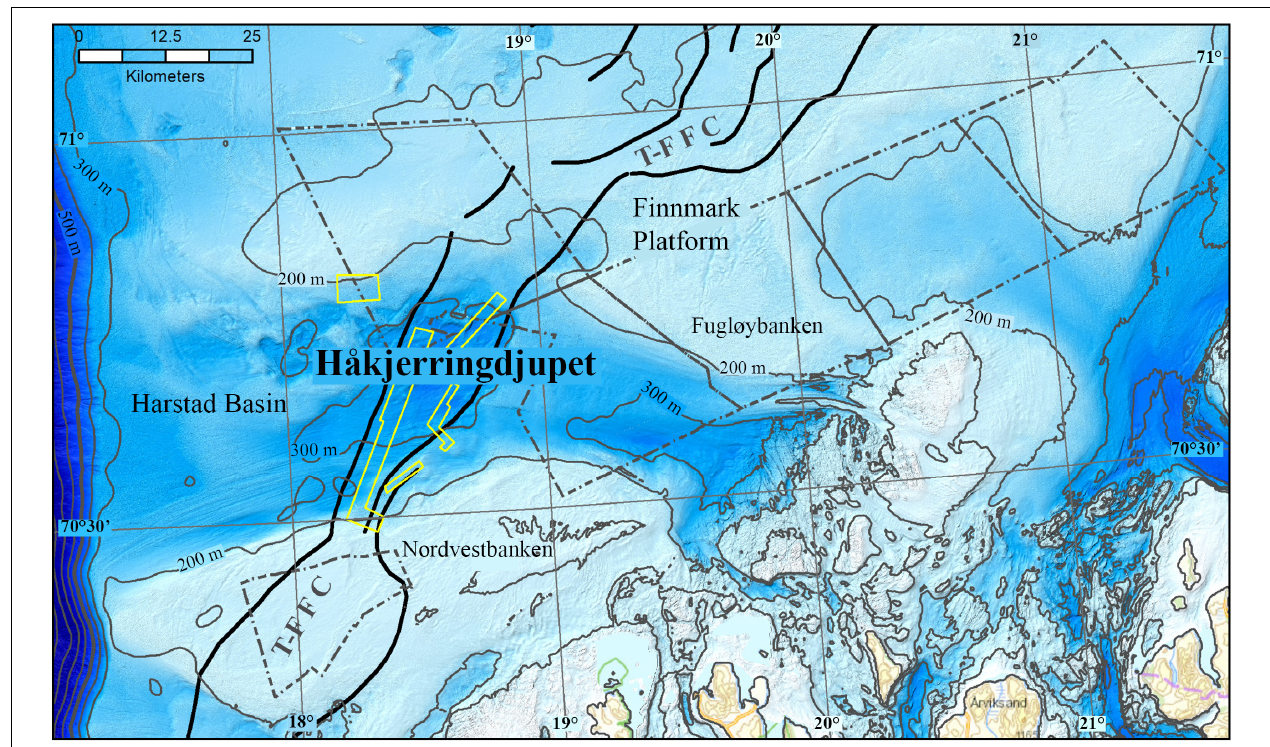
FIGURE 1 | The Håkjerringdjupet study area. Black lines – faults within the Troms-Finnmark Fault Complex (T-F F C). Stippled gray lines – extent of MAREANO multibeam data. Yellow lines – extent of other multibeam